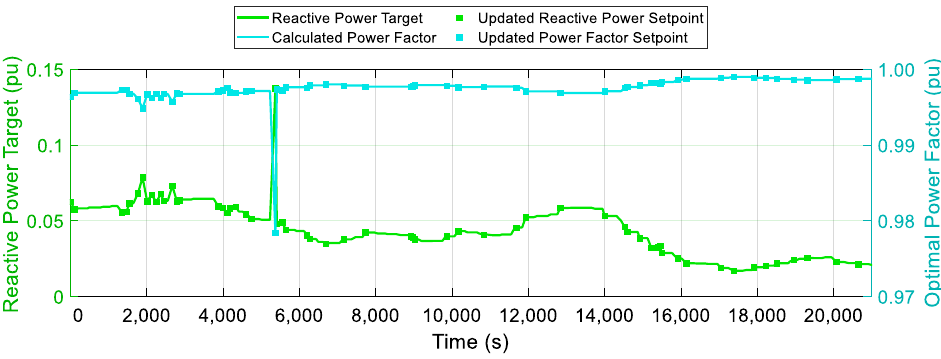
Figure 13. Calculate PF and Reactive Power Target solutions from the PSO OPF.